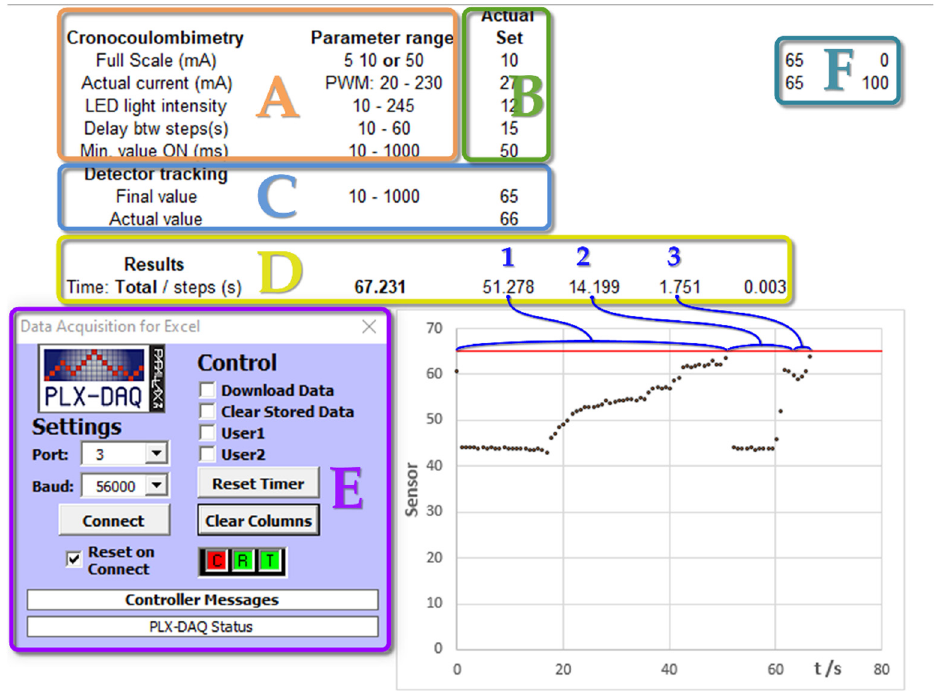
Figure 4. A screenshot of the spreadsheet interface for testing the entire coulometric titration program with a dummy cell and using the LDR as a light sensor. ( A ) Input parameters and verification ranges. ( B ) Actual value set. ( C ) Detector levels set. ( D ) Measurement results: numbers 1, 2, 3 refers to different experimental stages. ( E ) Add-on module for serial communication. ( F ) Plot scales.